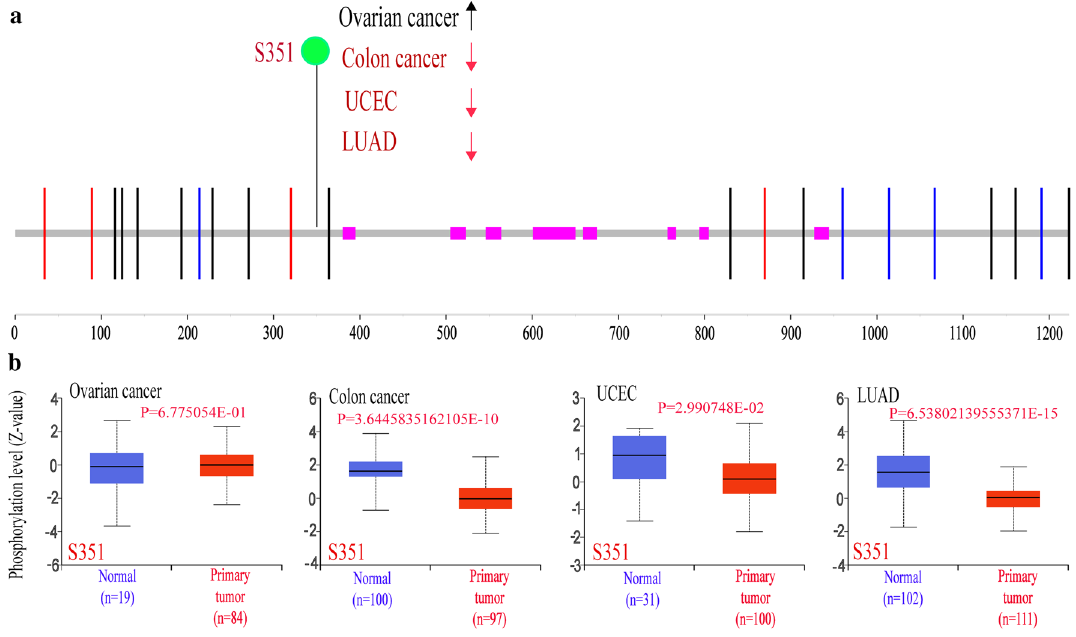
Fig. 4 Phosphorylation analysis of RIPOR1 protein in different tumors. a The phosphoprotein site (S351) is showed in the schematic diagram of the RIPOR1 protein. b The box plots of different tumors, including ovarian cancer, colon cancer, UCEC and